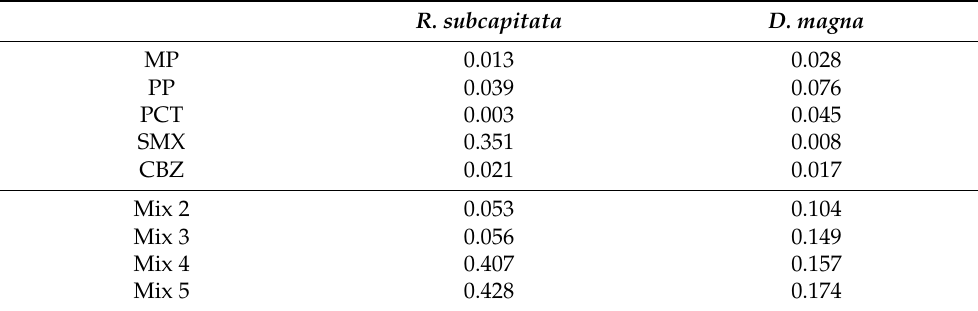
Table 5. Toxic unit (TU) and toxic unit summation (TUS) calculation considering the growth rate inhibition (72 h) of R. subcapitata and the immobilization (48 h) of D. magna . The EC 50 values selected from the literature for TU calculation are given in Table